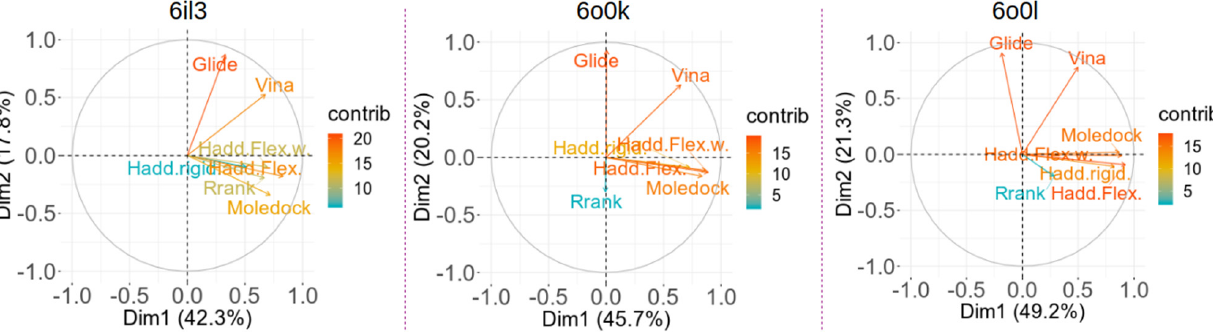
Figure 3. The distribution of the individual seven docking scores along with the two principal components with the quality of the contribution (cos2) of each to the PCA computed from the multivariance analysis to show their level of correlation. When the docking scores appear within close range to each other and are of a similar contribution to the PCA (similar color), then it shows a good level of correlation.